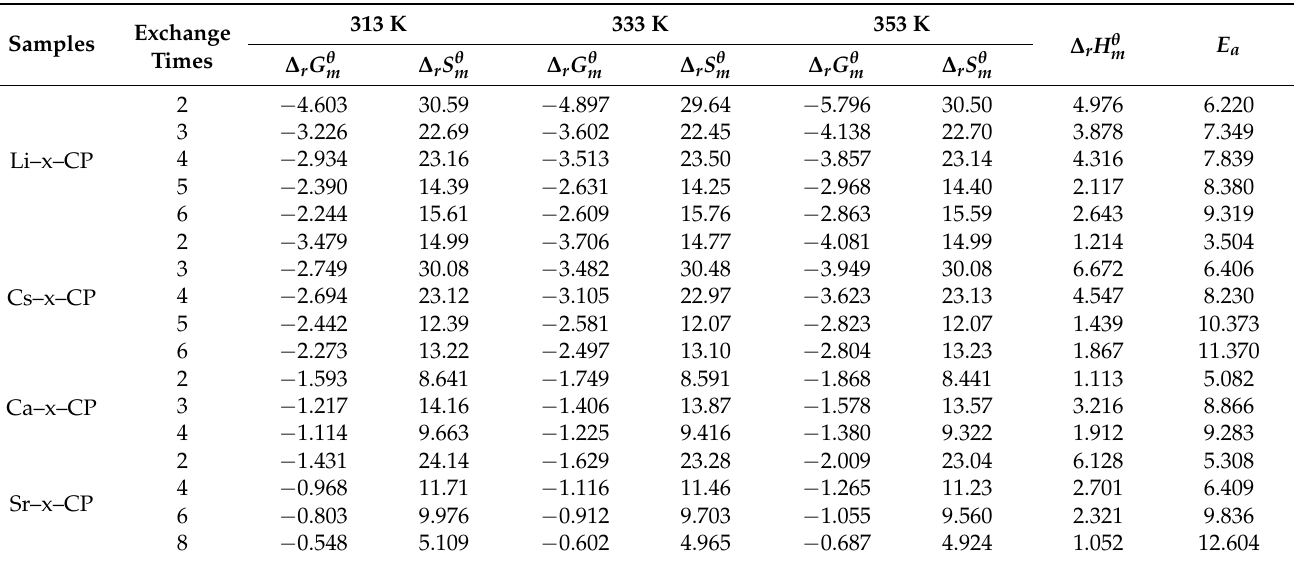
Table 2. Summaries for ∆ r G θ m (kJ/mol), ∆ r S θ m (J/mol k), ∆ r H θ m (kJ/mol), and E a (kJ) values of various cationic exchange process with NH 4